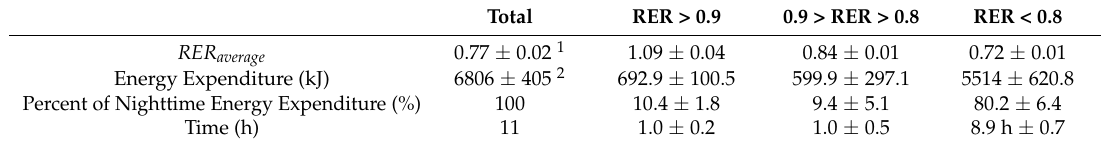
Table 1. Energy Expenditure during periods of selected RER ranges in fed